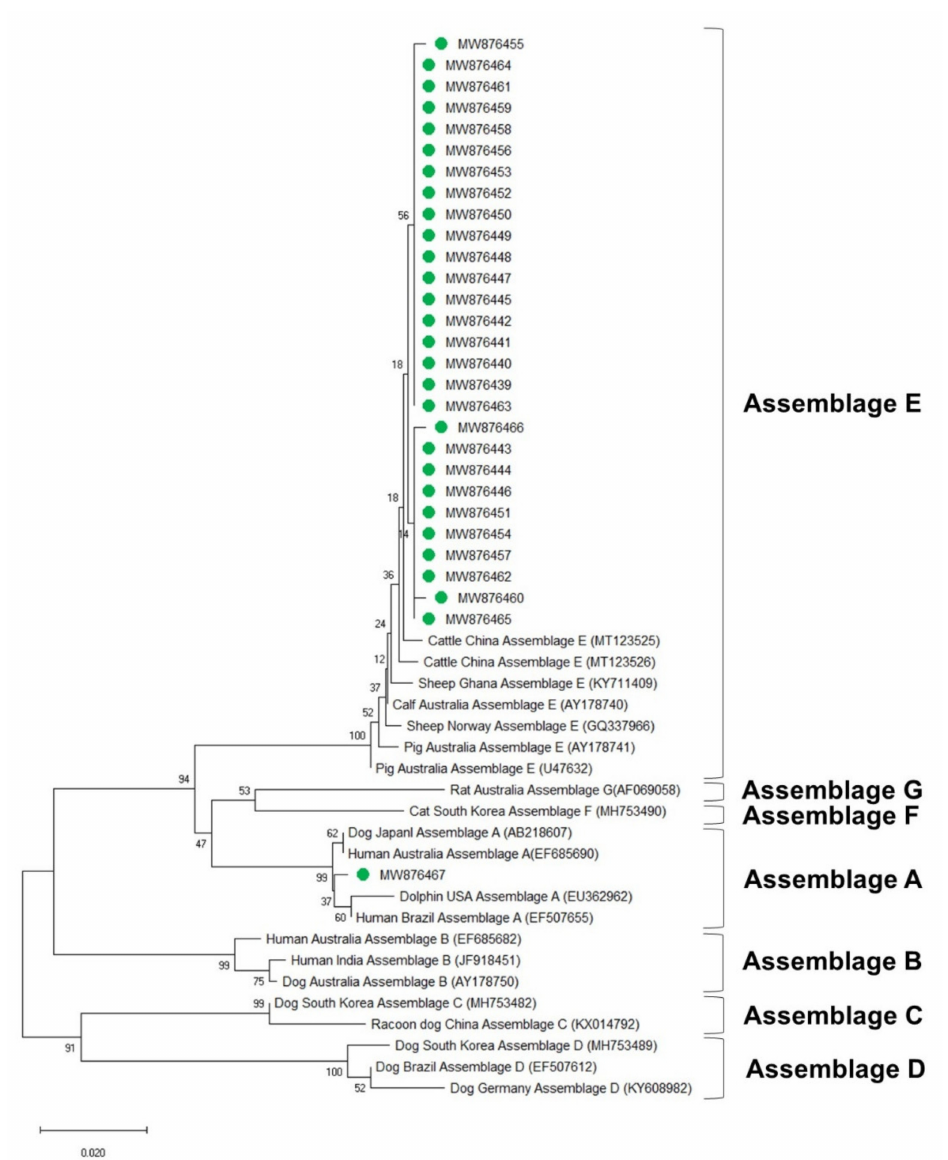
Figure 5. Phylogenetic tree of G. duodenalis based on GDH gene sequences. The neighbor-joining method was used to construct the tree; the green circles indicate the sequences detected in this study. The GenBank accession numbers are shown in parentheses, and the G. duodenalis assemblages are indicated with one-sided square brackets. Tree reliability was tested by running 1000 bootstrap